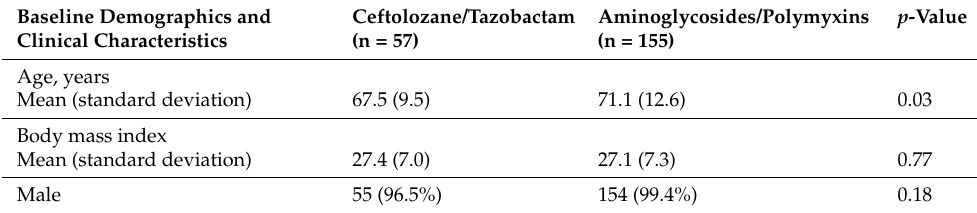
Figure 1. Flow chart for the study of cohort identification. Table 1. Baseline demographics and clinical characteristics of hospitalized patients with positive MDR Pseudomonas aeruginosa infections with ceftolozane/tazobactam or aminoglycoside or polymyxin treatment